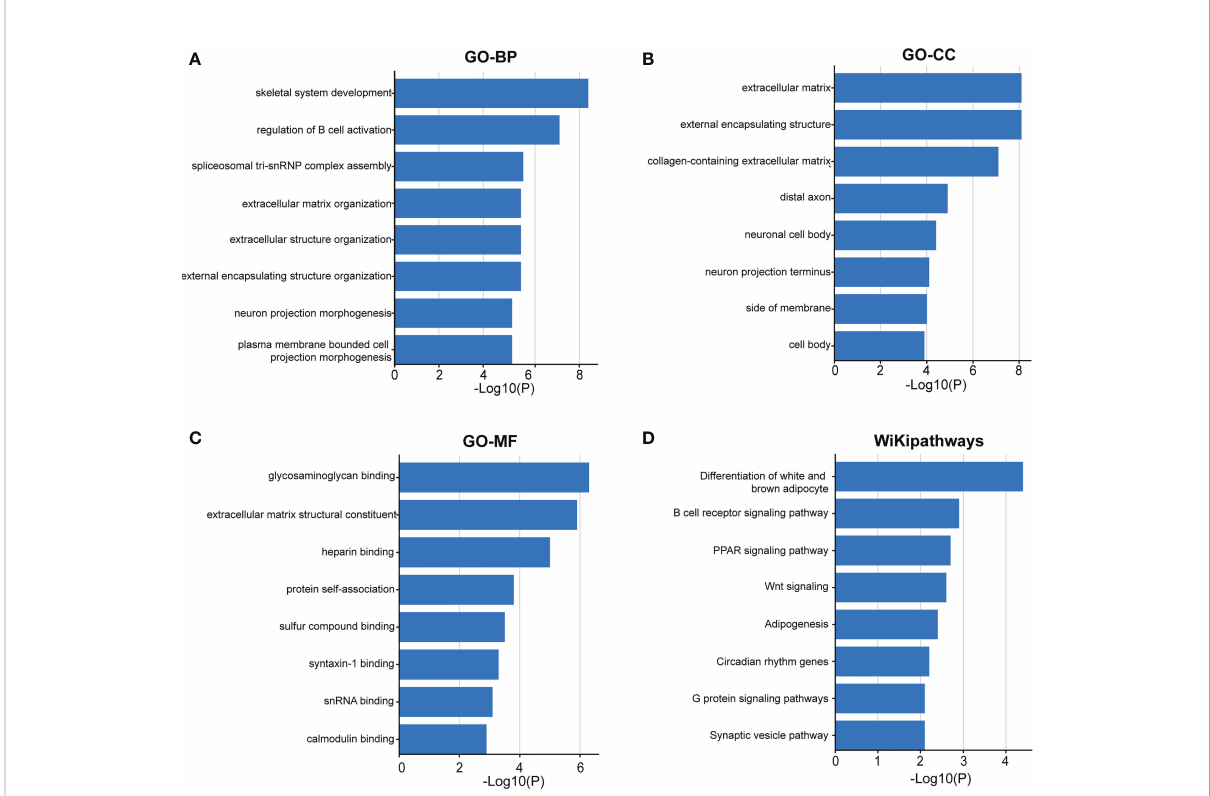
FIGURE 10 The functional enrichment analysis of the DEGs between the two groups. Gene Ontology analysis of BP (A) , CC (B) , MF (C) and WikiPathways (D) analysis of the DEGs between the high- and low-risk groups. BP, biological processes; CC, cellular components; MF, molecular functions; DEGs, differentially expressed genes.